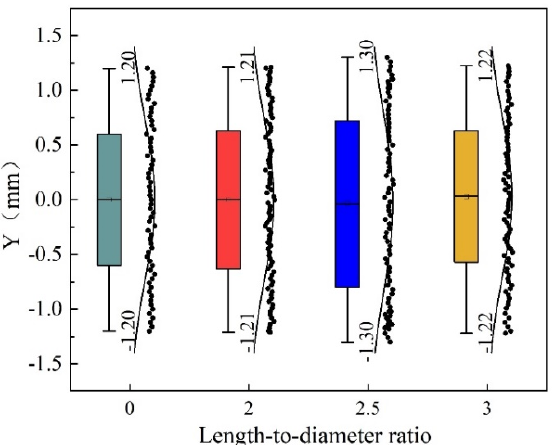
Figure 9. Effect of length-to-diameter on the effective Y-axis extension distance of water jet at X = 100 mm.